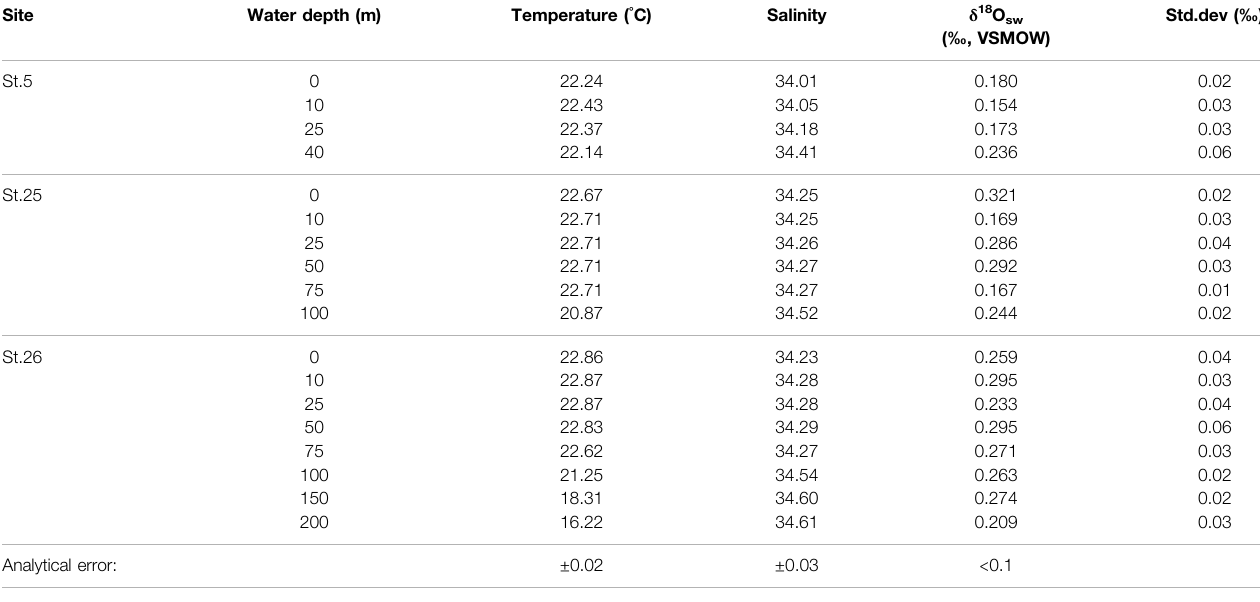
TABLE 2 | Temperature, salinity, and oxygen isotopic composition in seawater ( δ 18 O sw ) from three sites in Tosa Bay (November 20, 2009).